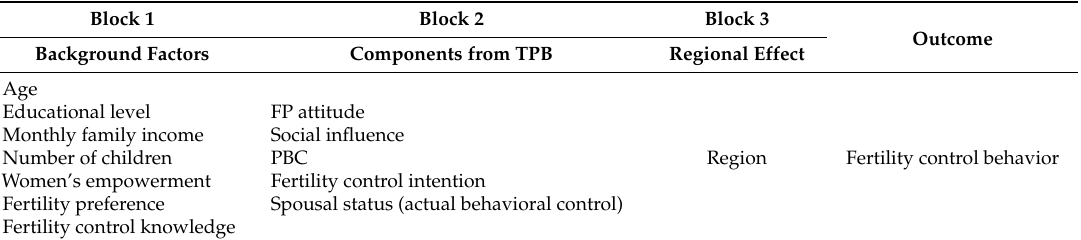
Table 1. Variables of hierarchical model to predict fertility control behavior of rural